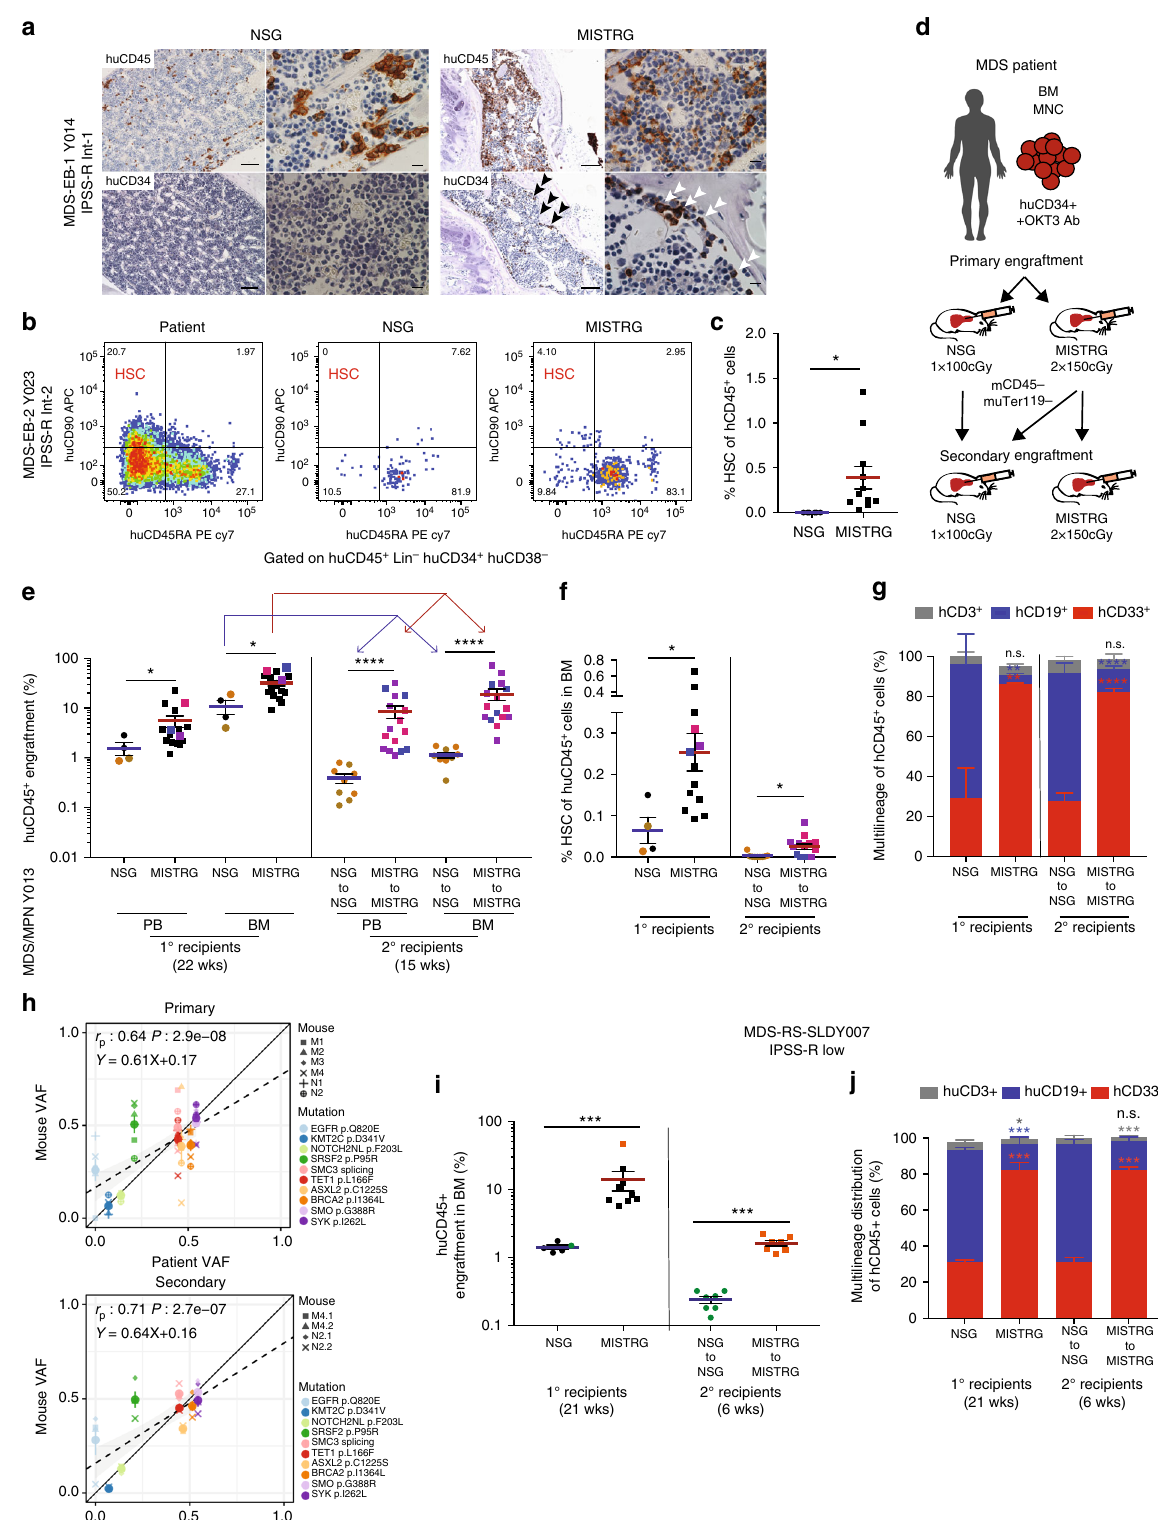
MISTRG mice, were signi fi cantly suppressed after administration of enasidenib (Fig. 6e). Variant allele frequencies of mutations identi fi ed in the patient were represented in all MISTRG mice and not signi fi cantly altered by enasidenib treatment (Fig. 6f, Supplementary Table 2).